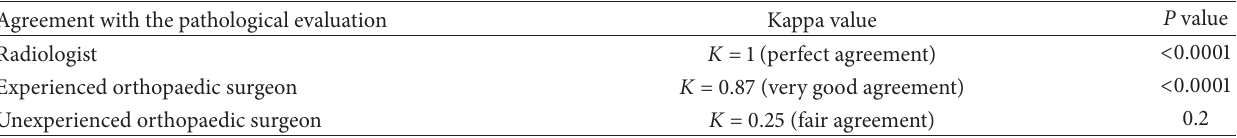
Figure 3: 43-year-old patient with undifferentiated osteosarcoma of the sacroiliac joint. Resection was performed with resection of iliac wing and sacral ala. Top-left: preoperative T2-weighted MRI of the tumor. Top-middle: postoperative T2-weighted MRI of the resected specimen. Top-right: segmentation of the tumour has been made on MRI in red color and of the whole specimen in green color for soft tissues and in grey color for bone tissue. Bottom-left: pathological picture of the margin in the encircled area. Tumoral cells are present at the margin, what was already visible on MRI. Bottom-right: a good margin is present at that location. Table 3: Agreement between pathological evaluation and MRI evaluation.